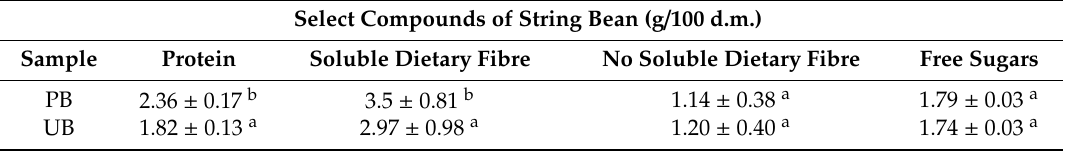
Table 1. Content of selected compounds in packed (PB) and unpacked (UB) string beans. Select Compounds of String Bean (g/100 d.m.)